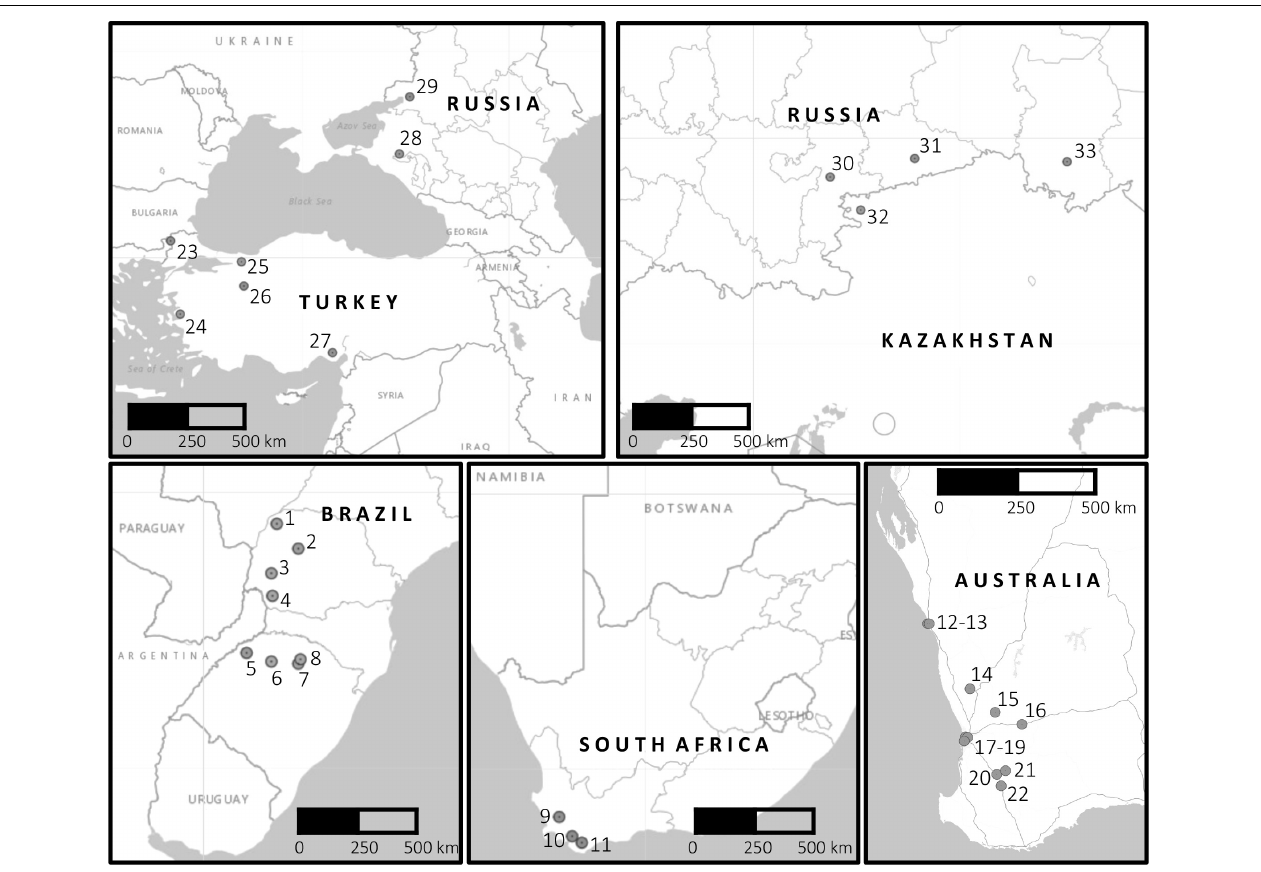
FIGURE 1 | Locations of origin of 346 Blumeria graminis f. sp. tritici isolates from six countries tested for virulence. Location numbers on the map correspond to the numbers in Table 1